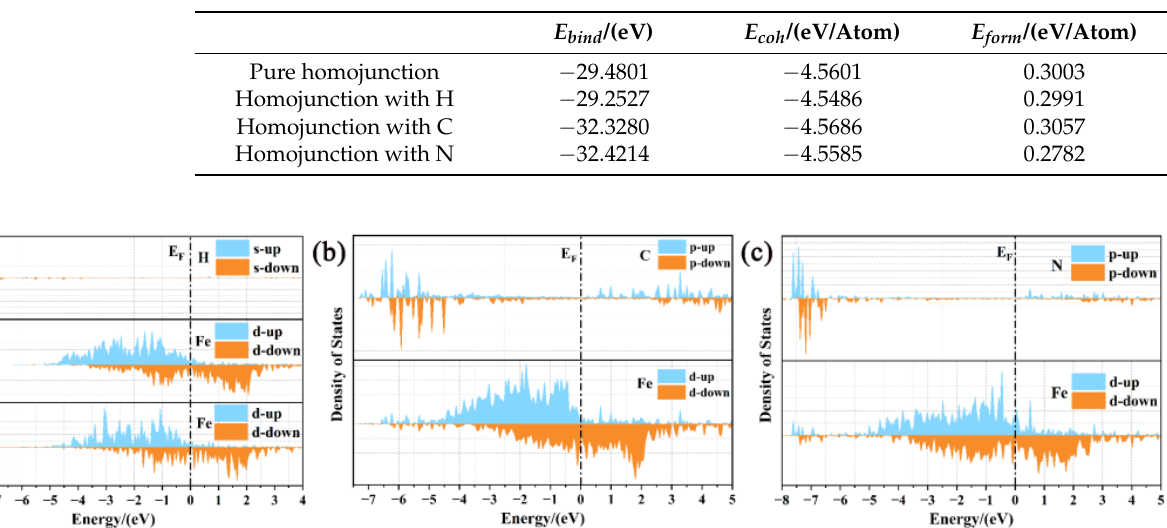
Figure 3. DOS of a H/C/N atom at the interface after optimization. ( a – c ) DOS of a H/C/N atom at the interface, respectively.